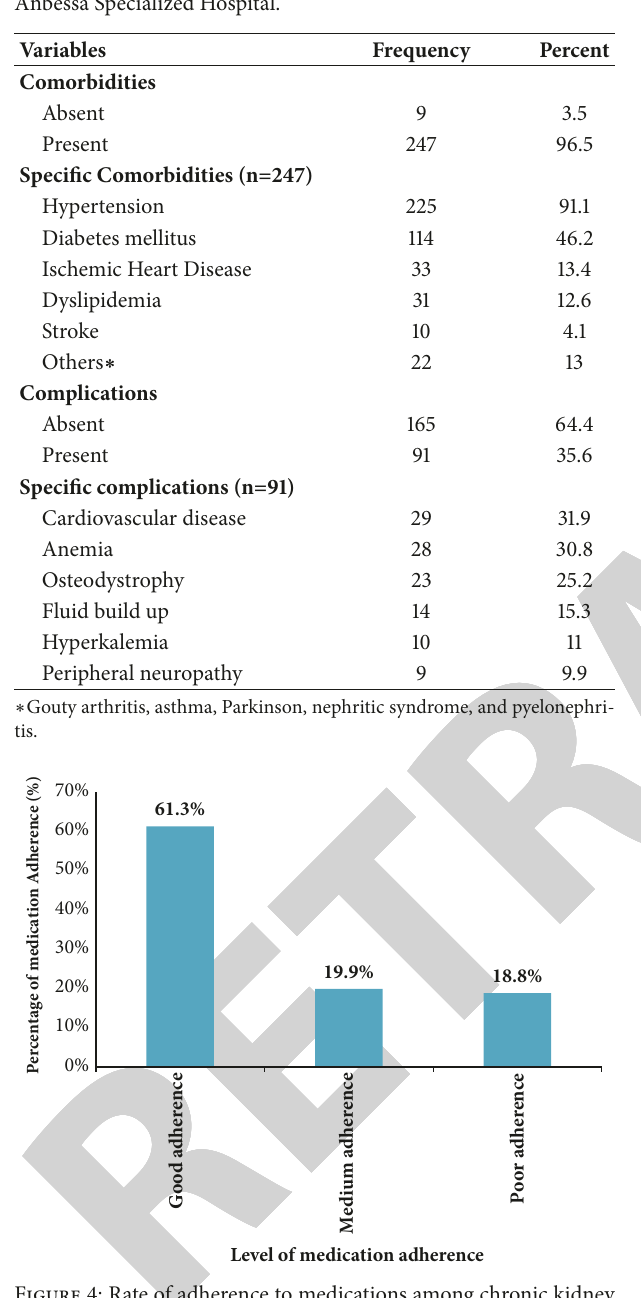
Figure 4: Rate of adherence to medications among chronic kidney disease patients in renal clinic of Tikur Anbessa Specialized Hospi- tal.